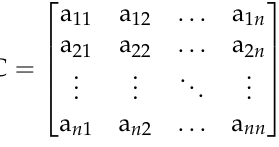
Table 2. Pair-wise comparison scale for AHP method.